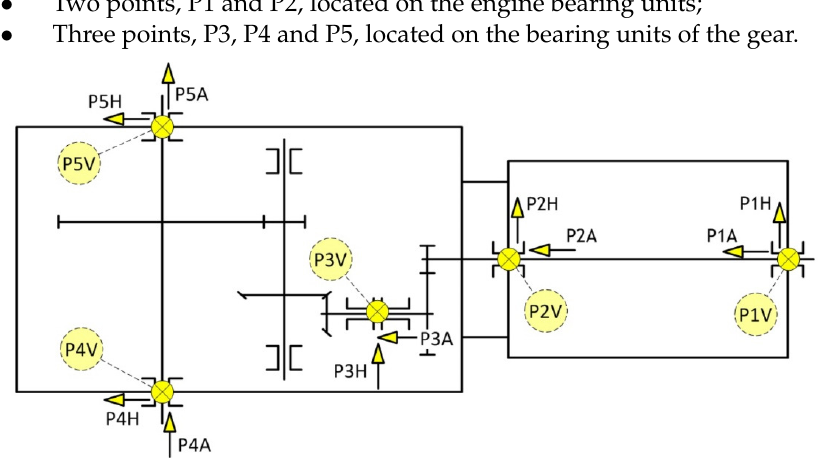
Figure 2. Location of measuring points on the drive unit.